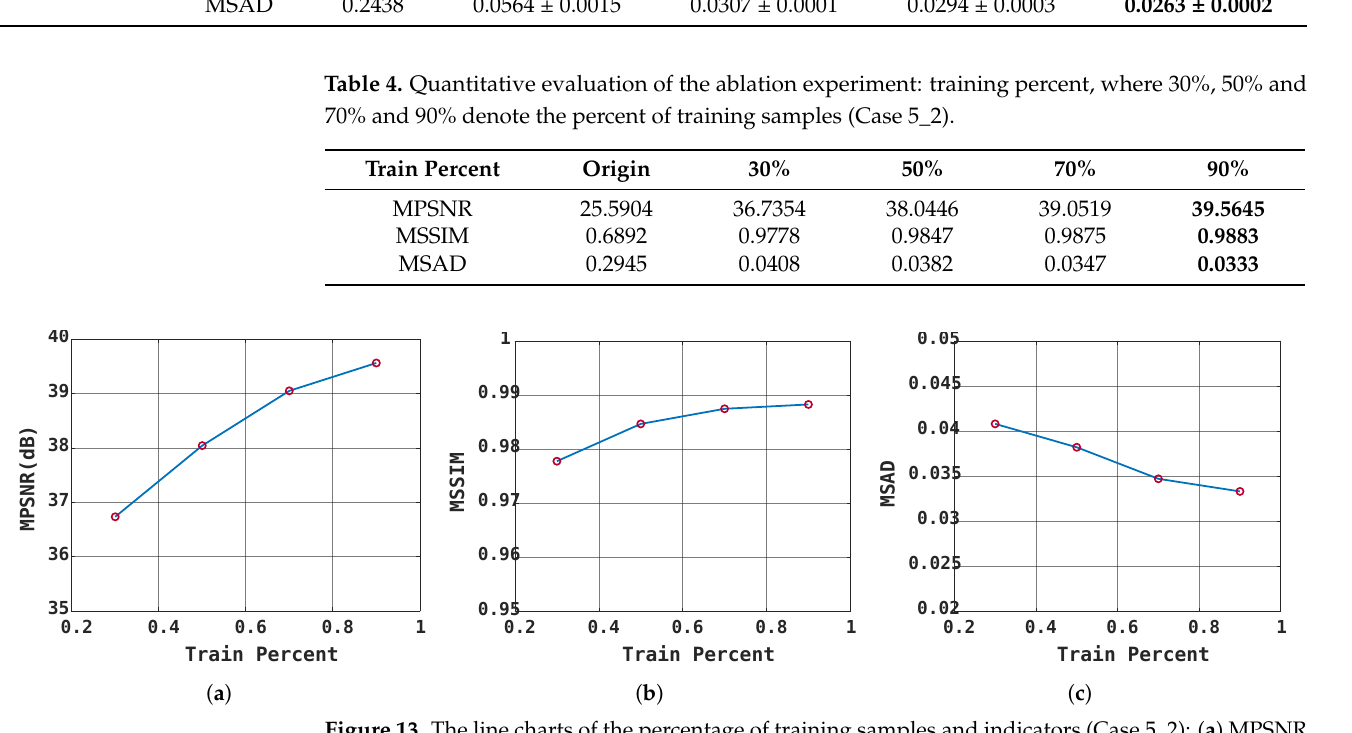
Figure 13. The line charts of the percentage of training samples and indicators (Case 5_2): ( a ) MPSNR (dB); ( b ) MSSIM; and ( c )